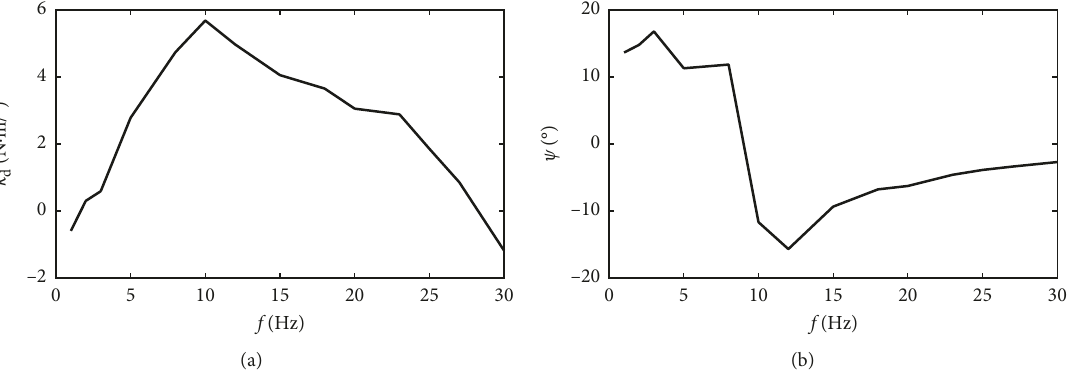
Figure 15: Model error curve with excitation amplitude of θ